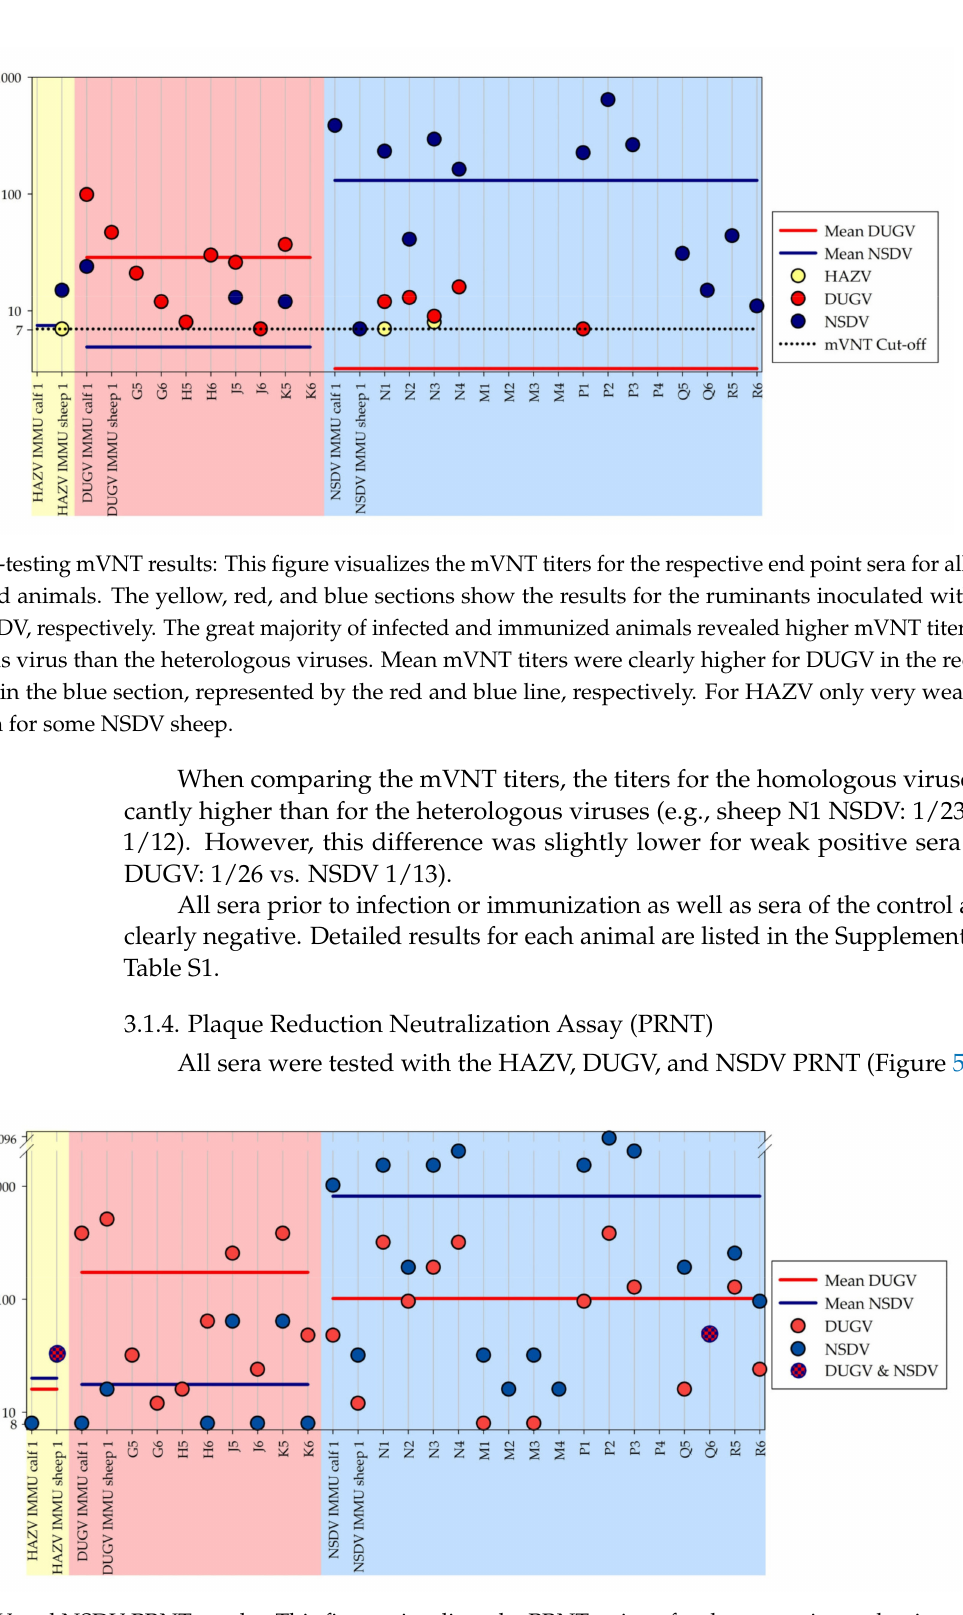
Figure 5. DUGV and NSDV PRNT results: This figure visualizes the PRNT 80 titers for the respective end point sera for all infected and immunized animals. The yellow, red, and blue sections show the results for the ruminants inoculated with HAZV, DUGV, and NSDV, respectively. The great majority of infected and immunized animals revealed higher PRNT 80 titers against the homologous virus than the heterologous virus from the same serogroup. Mean PRNT 80 titers were clearly higher for DUGV in the red section and for NSDV in the blue section, represented by the red and blue line,